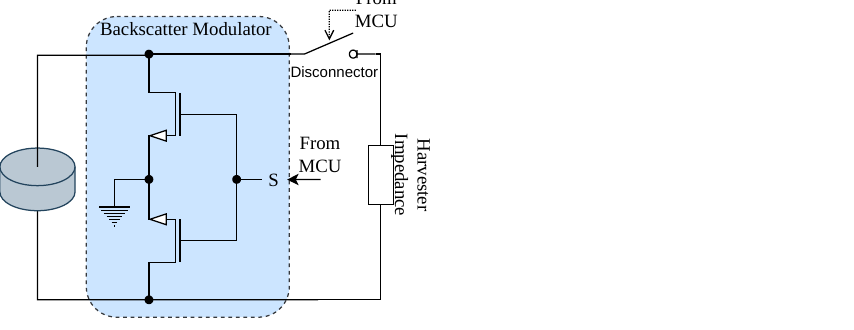
Figure 4. The modulator circuit switches the impedance presented to the piezo between the short- circuit and open-circuit